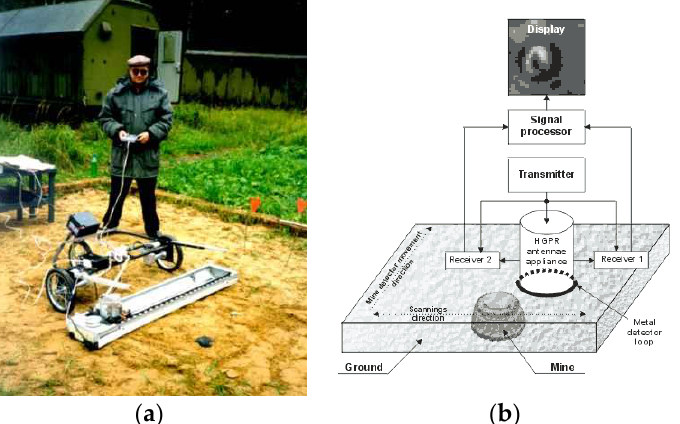
Figure 14. ( a ) Two-sensor MiRascan mine detection system and ( b ) block diagram of MiRascan HSR with MD. with